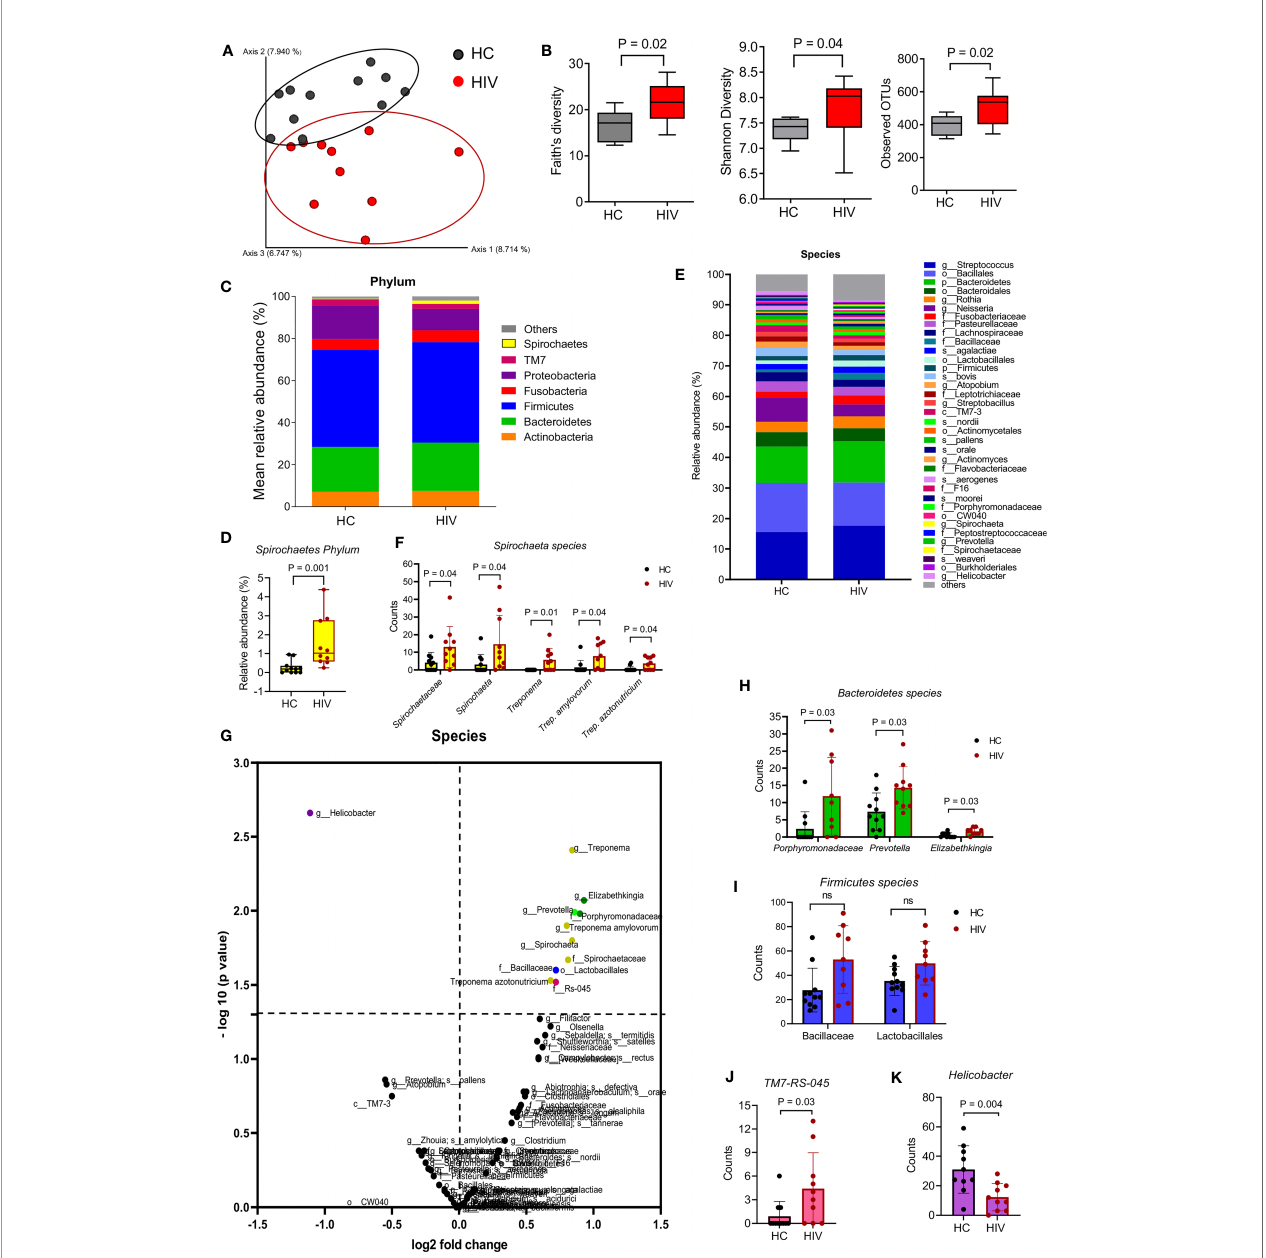
FIGURE 1 | Differential oral microbiome in the saliva of HIV-infected compared to healthy individuals. (A) Beta diversity in bacterial communities is shown by Principal coordinates analysis (PCOA) of Bray-Curtis Distances, in gray HCs (n = 11), in red HIV-infected individuals (n = 10), and each symbol represents an individual. (B) Alpha diversity in bacterial communities determine by Faith ’ s, Shannon ’ s, and observed OTUs indexes. (C) Comparison of the saliva microbiota at phylum level in HCs versus HIV-infected group. (D) Comparison of Spirochaete ’ s phylum in the saliva of HCs versus HIV-infected individuals. (E) Comparison of the saliva microbiota at the species level in HCs versus HIV-infected group. Approximately, 32% of all taxa resolved could be classi fi ed at the species level. All other taxa are also included in the barplot at the lowest level they could be resolved (see legend: s_: species, g_: genus, f_: family, o_: order, c_ class, p_: phylum). (F) Comparison of unclassi fi ed Spirochaetaceae, Spirochaeta, Treponema, Trep. amylovorum , and Trep. Azotonutricum from Spirochaete ’ s phylum in the saliva of HCs versus HIV-infected individuals. (G) The volcano plot comparing bacterial Genus in the saliva samples from HCs versus HIV-infected individuals. All genus that exceeded the dotted line marked at 1.3 were considered signi fi cant. (H) Comparison of Bacteroidetes genus members Prophyromonadaceae, Prevotella, and Elizabethkingia in saliva samples of HCs versus HIV-infected individuals. (I) Comparison of Firmicutes genus members Bacillaceae and Lactobacillales in saliva samples of HCs versus HIV-infected individuals. (J) Comparison of Sebaldella genus from Fusobacteria phyla (TM7-RS=045) in saliva samples of HCs versus HIV-infected individuals. (K) Comparison of Helicobacter genus in saliva samples of HCs versus HIV-infected individuals. ns, no signi fi